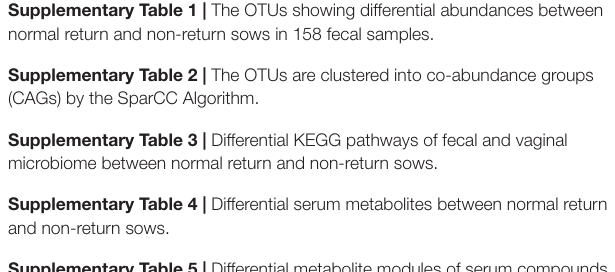
Supplementary Figure 3 | Comparative analysis of the α -diversity and β -diversity of microbiota between normal return and non-return sows in vaginal swab samples. (A) Comparison of the α -diversity (observed species and Chao index) in the vaginal samples between normal return and non-return sows. (B) PCoA of vaginal microbiota based on Weighted UniFrac distance and Unweighted UniFrac distance between the normal return and non-return sows. Supplementary Figure 4 | The OTUs showing different abundances between normal return and non-return sows in 13 feces samples from sows that had serum metabolome data. LEfSe analysis was used to identify the differential OTUs between the two groups (| LDA| score > 2, p < 0.05). Supplementary Figure 5 | Comparison of the microbial compositions of feces and vaginal swab samples among seven parities by PCoA based on weighted UniFrac distance. (A) Feces samples; (B) vaginal swab samples. The results showed that the effect of parity on the microbial compositions of feces and vaginal